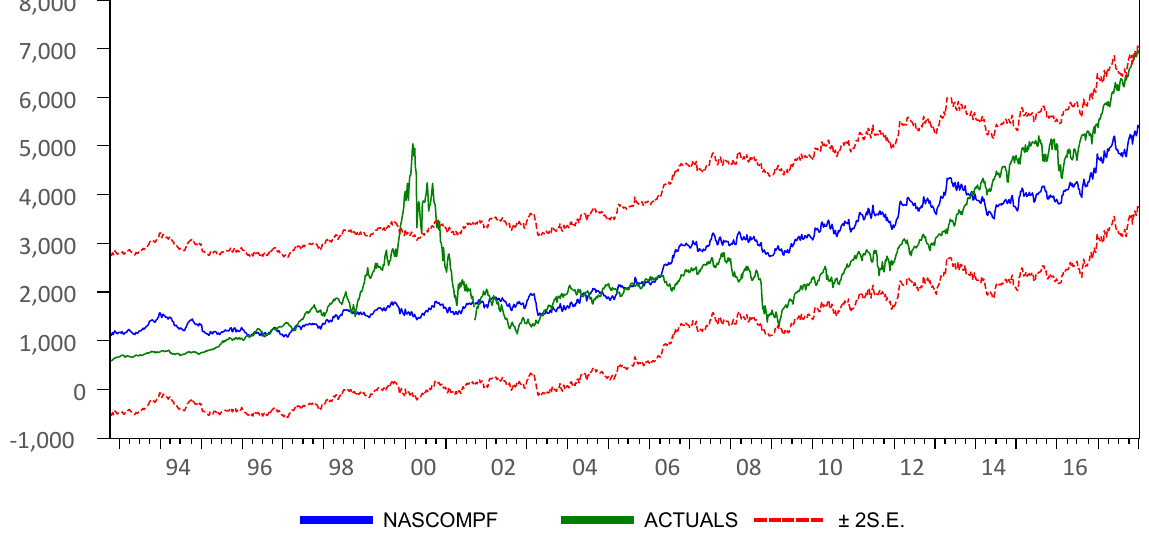
Figure 4. Actual and estimated market index